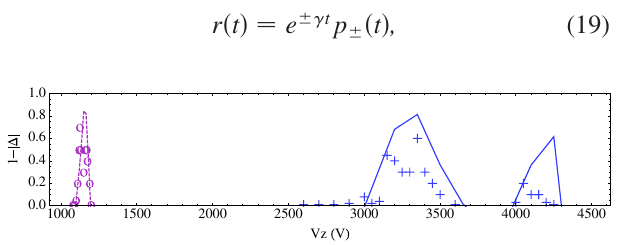
FIG. 9. These curves show 1 (cid:1) j (cid:3) j as a function of V tial applied to the lens) in two distinct cases: (right curve, þ ) is the trapping efficiency of Ar þ at 4.2 keV with the same con- ditions as in [36]. The set of points is a reproduction of the experimental data in their Fig. 3(a). The left curve, o, represents the trapping efficiency of Ar þ at 1.2 keV with the same con- ditions as in [10]. The set of points is a reproduction of the experimental data in their Fig. 8. There is very good agreement between theory and experiment.